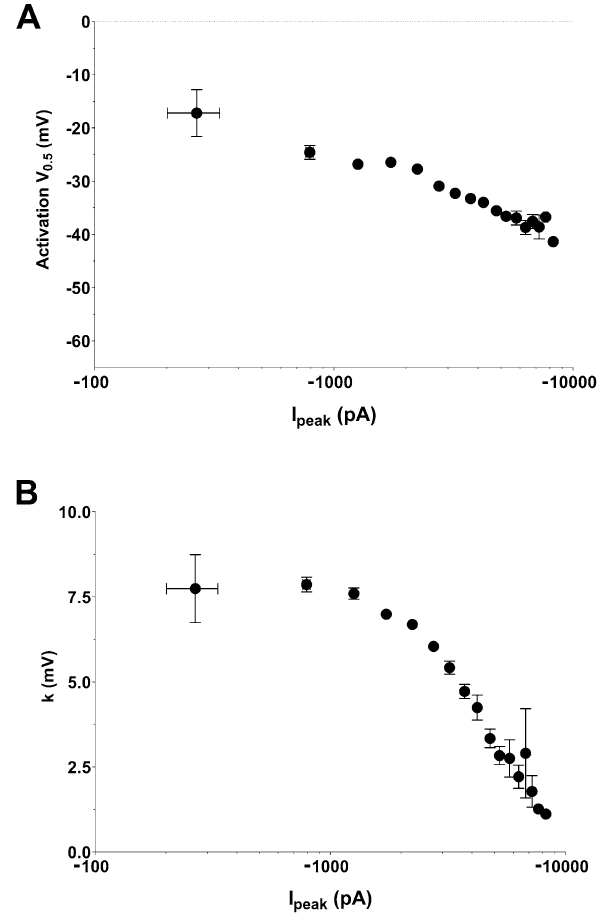
Figure 9. V 0.5 vs. amplitude plots and slope vs. amplitude plots for I Na in HEK293 cells stably expressing Na v 1.5 measured using a Nanion Syncropatch 384PE. (A ) Symbols represent the mean ± sem of pooled values of V 0.5 as a function of mean ± sem values of current amplitudes. Data points were pooled by 500 pA amplitudes intervals (0–500, 500–1000, etc.) ( B ) Pooled experimental values of the activation slope as a function of mean ± sem values of current